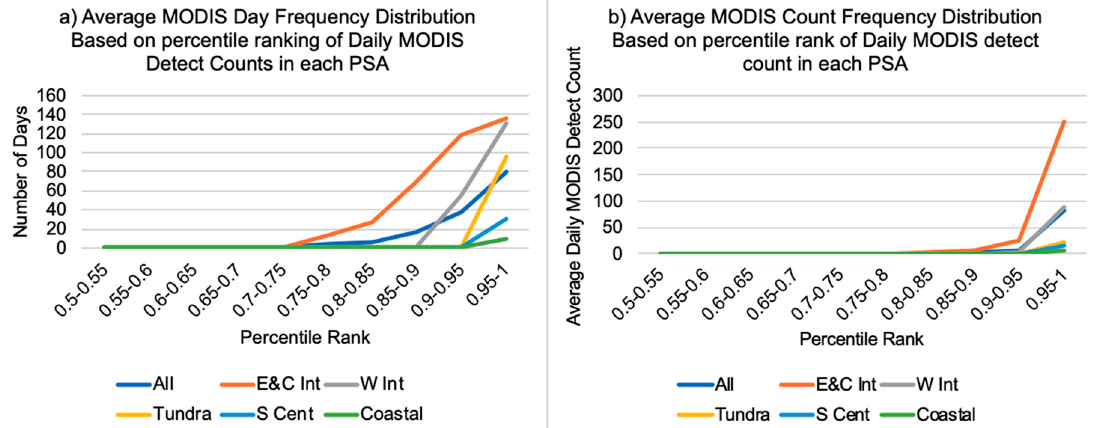
Figure 5. Distribution of active fire history over the 15-year study period. Subregion and statewide trends for ( a ) MODIS Day historical frequency distribution. ( b ) MODIS active fire detection count historical frequency distribution.